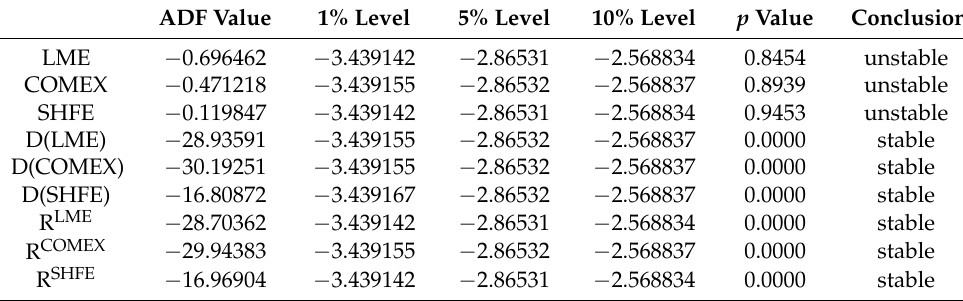
Table 1. Test of unit root ADF stationarity before the 2008 financial crisis.